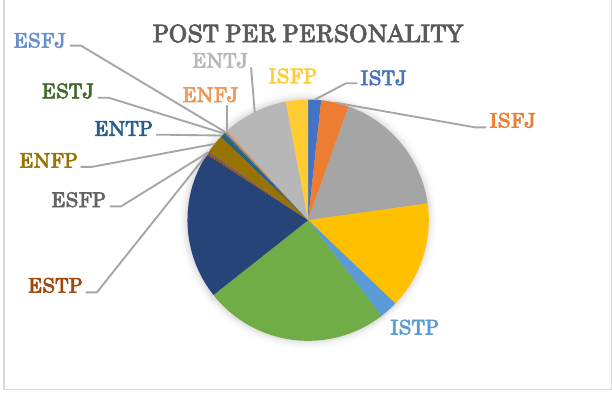
Fig. 1. Distribution of personality type per post